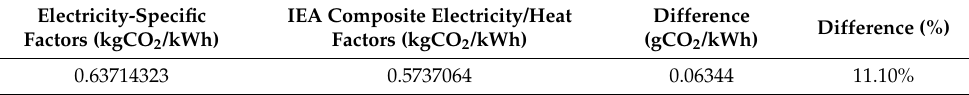
Table 14. IEA composite electricity/heat factors of